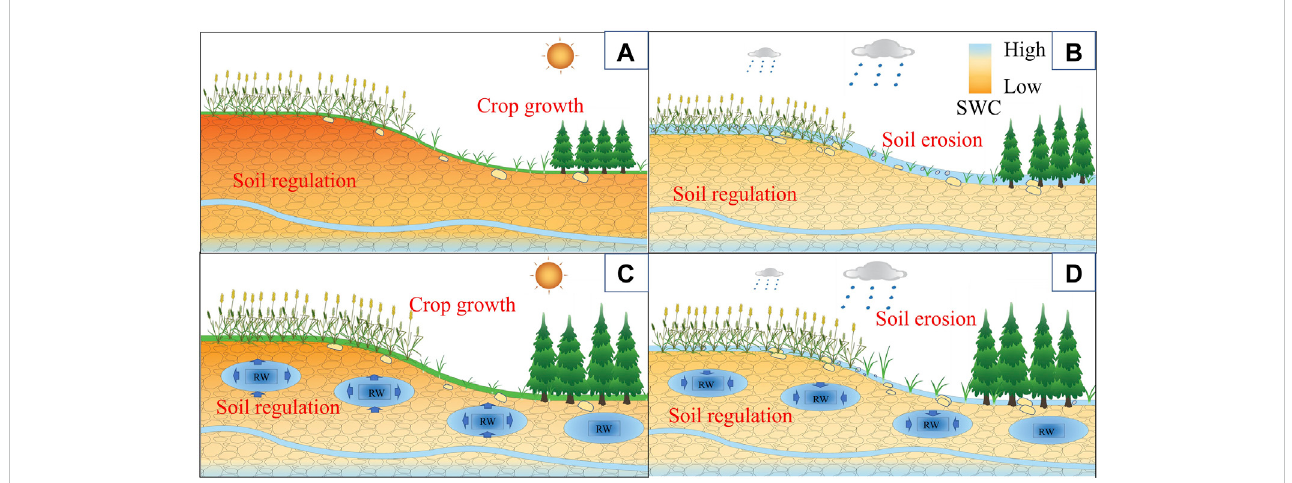
FIGURE 1 RW embedding in the farmland increases soil porosity, which bene fi ts from reducing runoff, thereby improving soil water and nutrient distribution, and ultimately promoting crop production. Pictures (B, D) represent RW can absorb the rainwater and reduce the runoff owing to its high porosity. Pictures (A, C) represent the soil water will be in fi ltrated, evaporated, or absorbed by the vegetation, and the water in the RW will be released to the surrounding soil and alleviate the soil moisture de fi cit, which makes the wheat grow well during a drought.